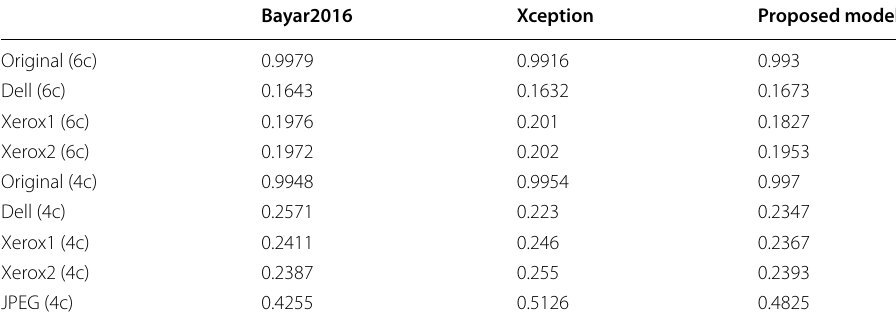
Table 3 Validation accuracy for various validation sets after training on IFSTC data set